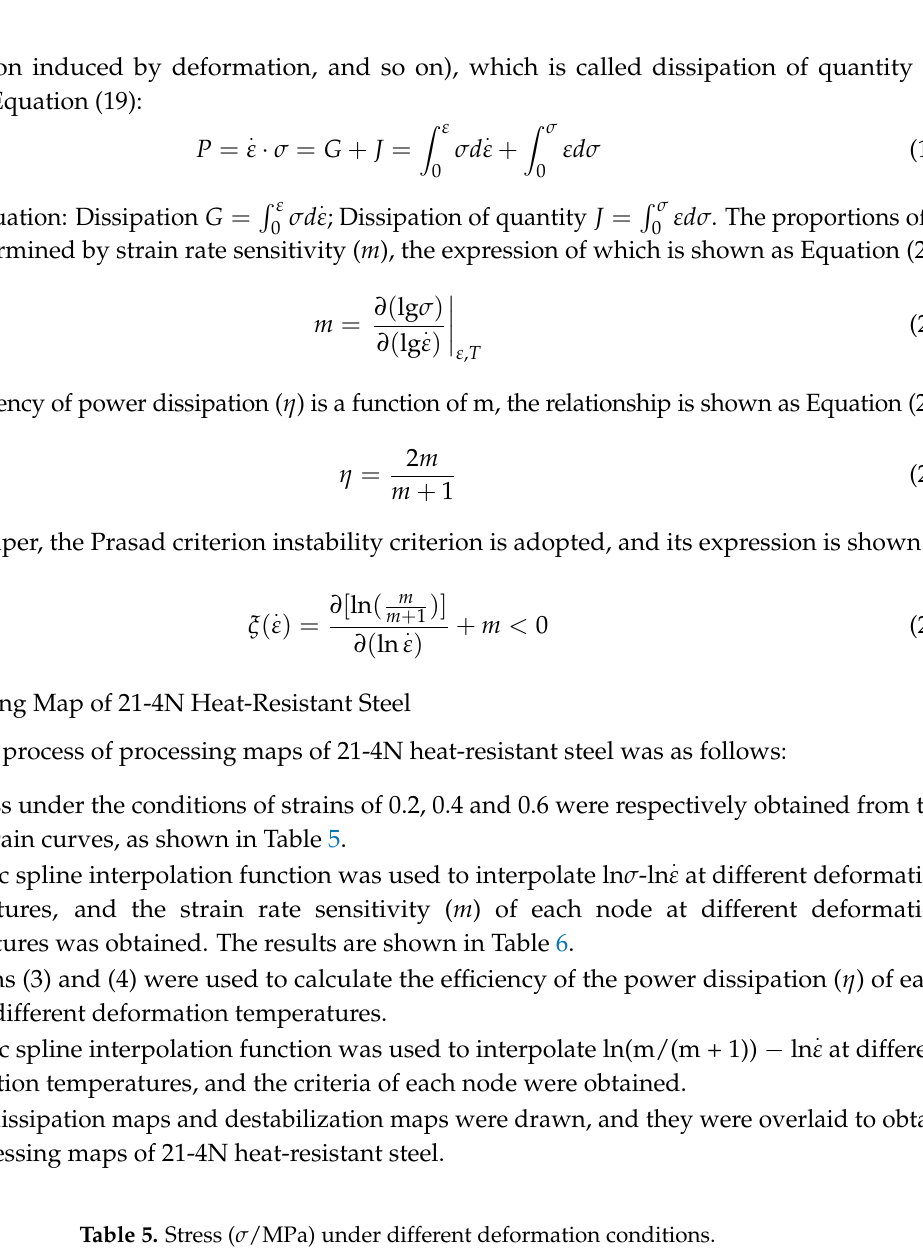
Table 4. The relative error ( ARRE ) between theoretical and corrected experimental. Table 5. Stress ( σ /MPa) under different deformation conditions. Strain T / ◦ C